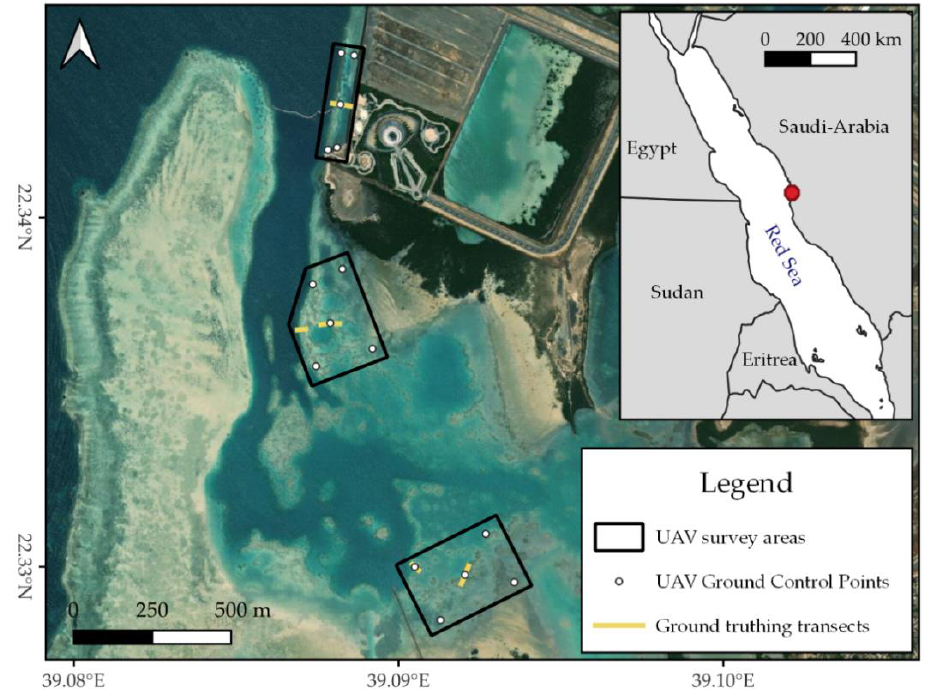
Figure 1. Map indicating the study areas in the KAUST lagoon. The white numbers are used to differentiate between the three survey areas. Inset indicates the general location of the KAUST lagoon on the Saudi Arabian Red Sea coast. Map contains ESRI World Imagery and Natural Earth data. All maps in this work were created with QGIS